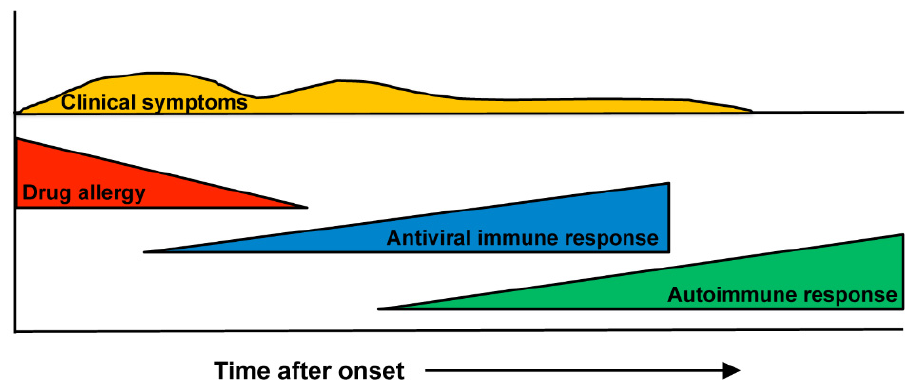
Figure 1. Scheme depicting the clinical course and immunological mechanism involved in DIHS/DRESS. DIHS/DRESS are considered to occur as a result of complex interactions between several herpesviruses and comprehensive immune responses, including drug-specific immune responses and antiviral immune responses. After the resolution of the disease, autoimmune responses may appear.